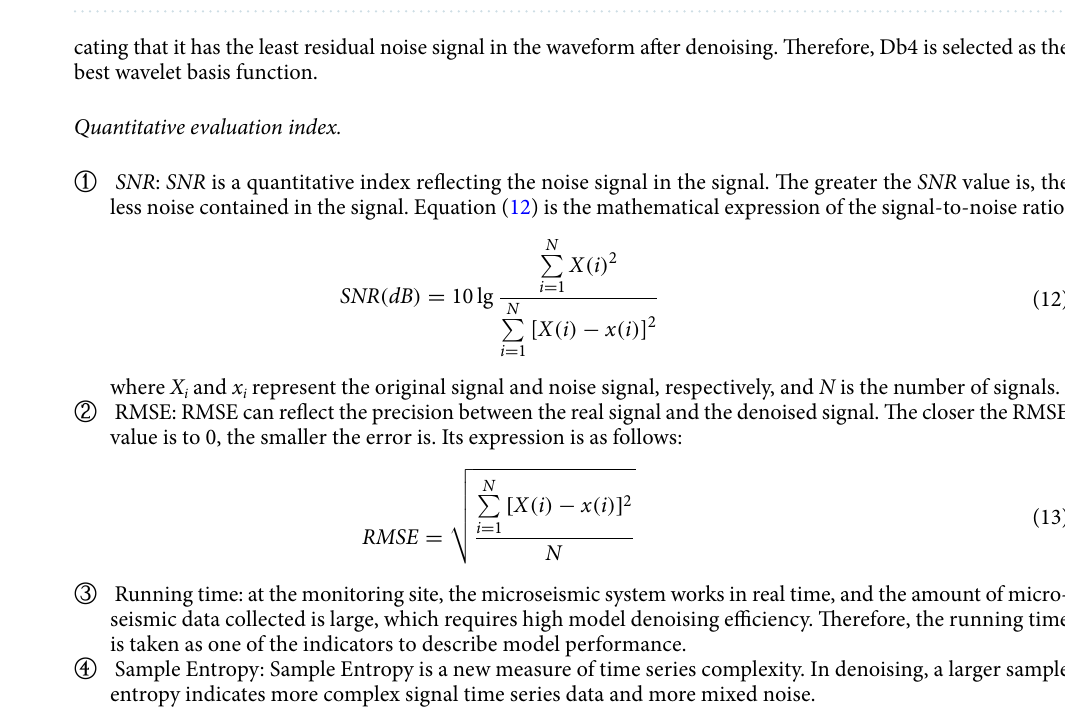
Figure 8. Characteristic description of analog signal and pollution signal (Spyder(Python3.6)) ( a ) Original signal ( b ) Polluted